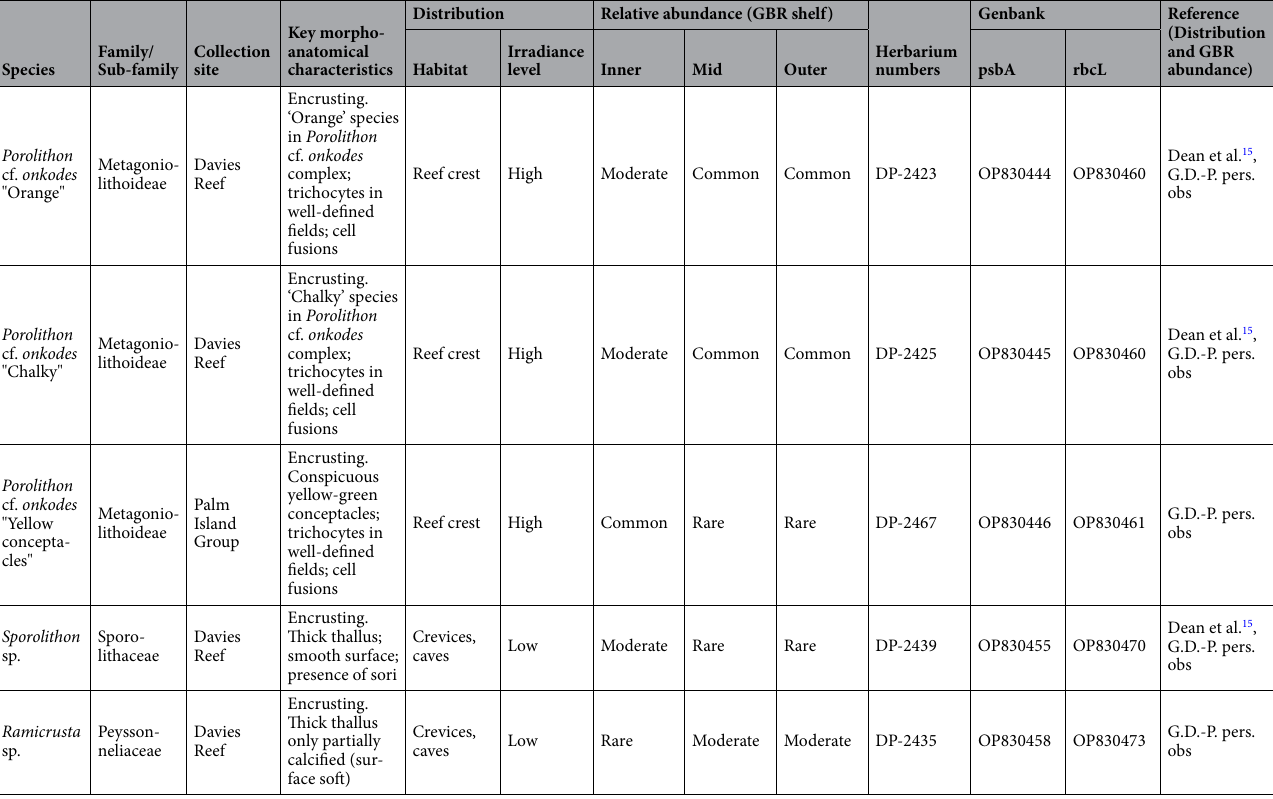
Table 2. Taxonomic, morphological characters and ecological distributions (habitat types, irradiance and relative abundance across the Great Barrier Reef) of CCA species tested in this study. Herbarium numbers refer to the collection of Diaz-Pulido at Griffith University, Brisbane, Australia. Representative sequences of each CCA species for the psb A and rbc L gene regions were submitted to GeneBank. G.D.-P. refers to Guillermo